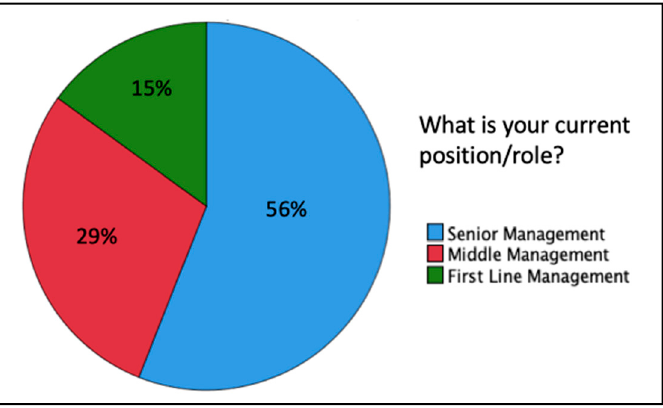
Figure 1 . Respondent Position. Figure 1. Respondent